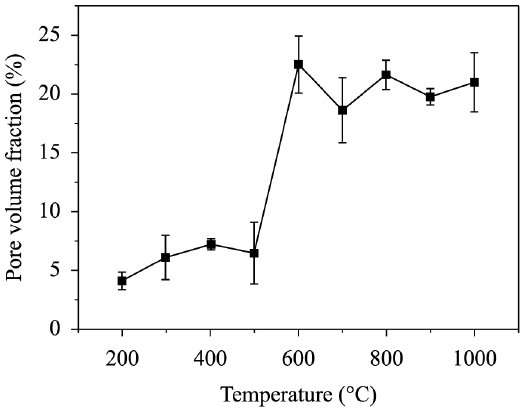
Figure 7. Volume fraction of pores as a function of temperature according to Figure 5.